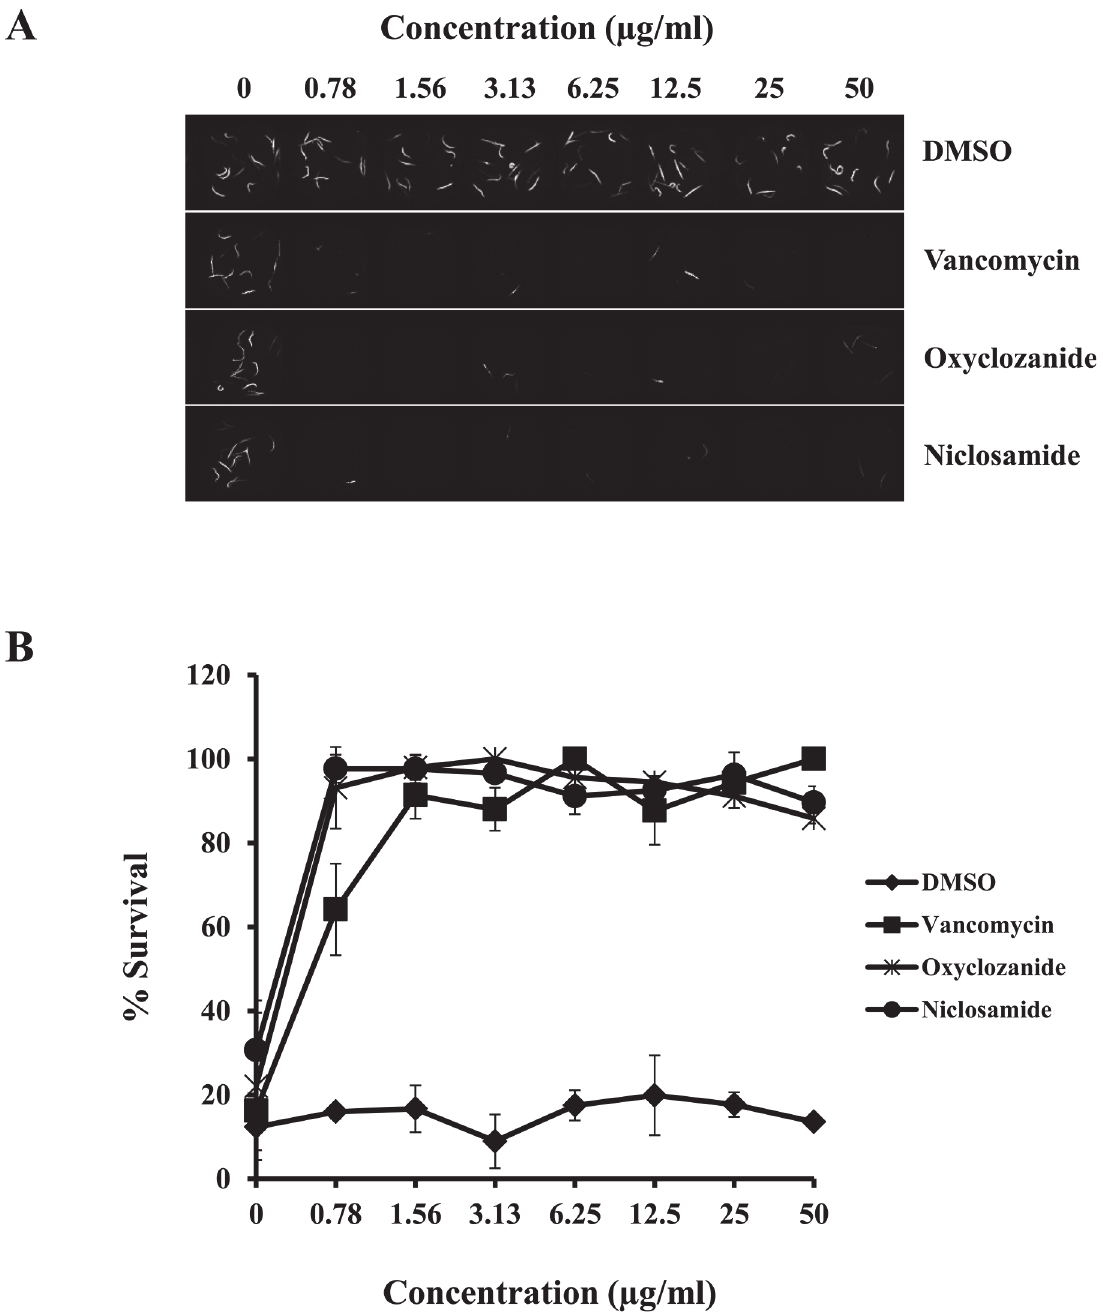
Fig 2. Salicylanilide anthelmintic drugs prolong survival of C . elegans infected with MRSA. A 384 well assay plate was co-inoculated with nematodes, bacteria and either DMSO (negative control), vancomycin (positive control) or the salicylanilide anthelmintic drugs. Serial dilutions of the drugs were tested to adjust the concentration between 0.78 – 50 μ g/ml. (A) Sytox Orange stained and bright field images of assay wells containing a gradient of the tested drugs. Dead worms take up the vital dye Sytox Orange and fluoresce. (B) Percent survival of infected worms was calculated from intensity of fluorescence measured in each well of the assay